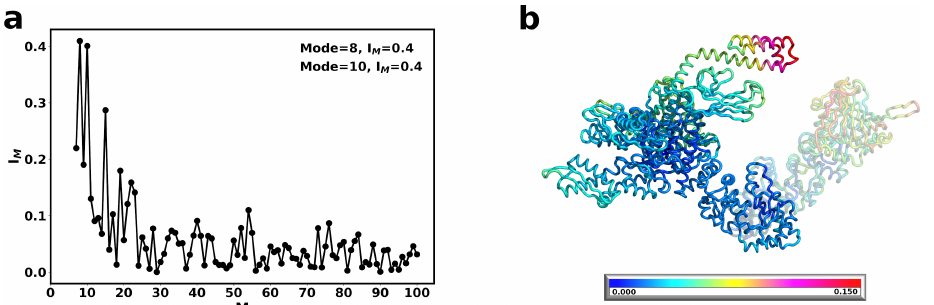
Figure 4. Normal modes of asymmetric DnaK bound Hsp90 Ec ( a ) Structural overlap of DnaK bound Hsp90 Ec model with ADP bound Hsp90 Ec to identify the dominant modes that contribute to the biological movement. The closed circles represent the overlap for individual modes. Lines are drawn for clarity. Nonzero modes with the highest structural overlap are considered. ( b ) The sum of the individual amino acid fluctuations in both modes 8 and 10 are represented on the structure of Hsp90 Ec . Blue represents static residues while red highlights highly mobile